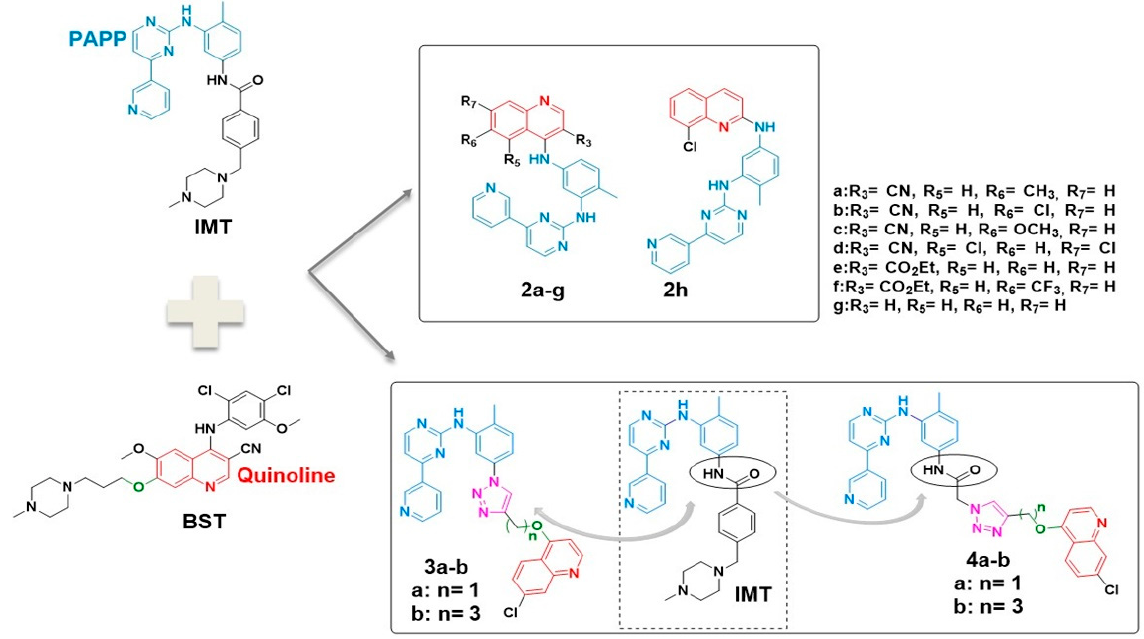
Figure 3. Design of the imatinib hybrids ( 2a – h ; 3a – b ; 4a – b ).